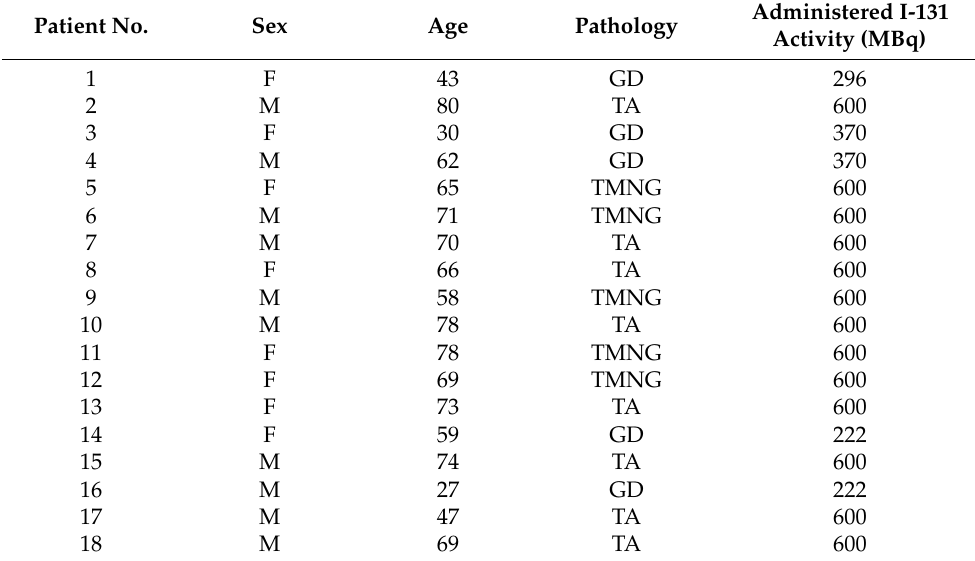
Table 4. Patient characteristics and administered I-131